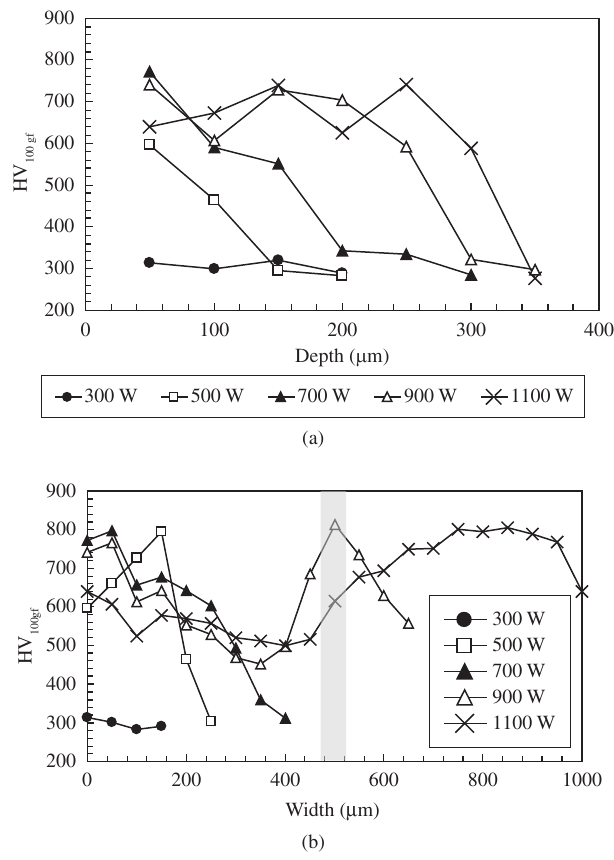
Figure 6. Microhardness profile for each laser power as a function of a) depth; and b) width. The gray area corresponds to the intersection between consecutive laser